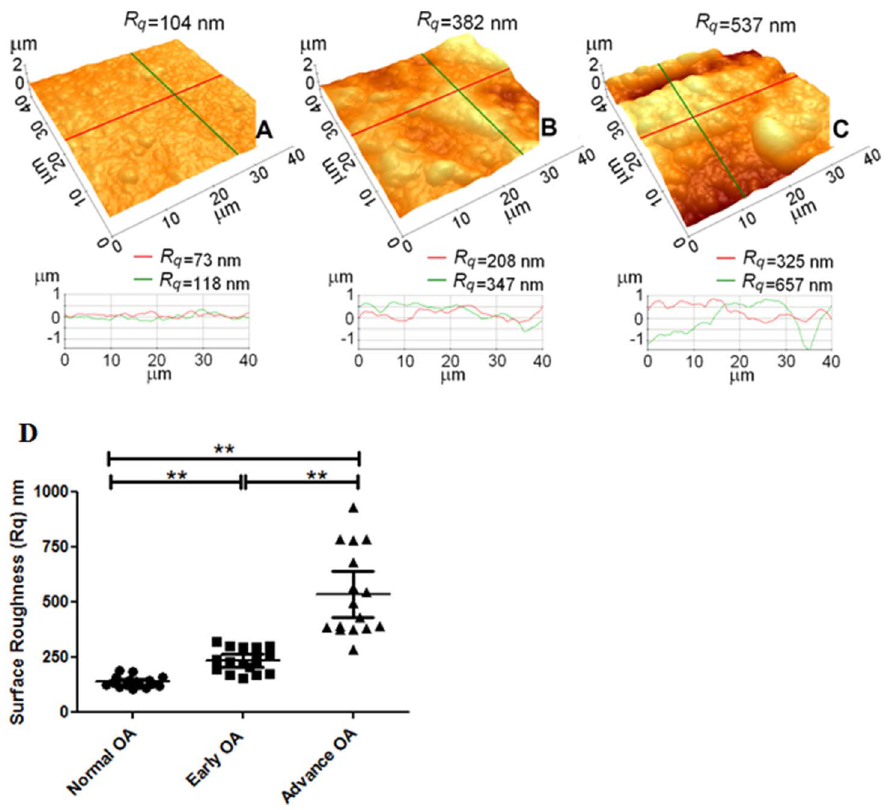
Figure 6. Typical AFM images of human cartilage surfaces with OA and line profile analyses measured in PBS, showing severe wear on the cartilage surface with an advanced stage OA. (A) normal cartilage, (B) early OA cartilage, and (C) advanced OA cartilage. (D) Surface roughness (Rq) of human articular cartilage of normal, early and advanced OA in PBS solution, represents significant increase in Rq value with increasing OA stages. (**P , 0.0001). The values of Rq were from 16 different locations on two cartilage samples of each OA score from a single femoral head. Vertical bars represent 95% of confidence interval (no of observation 5